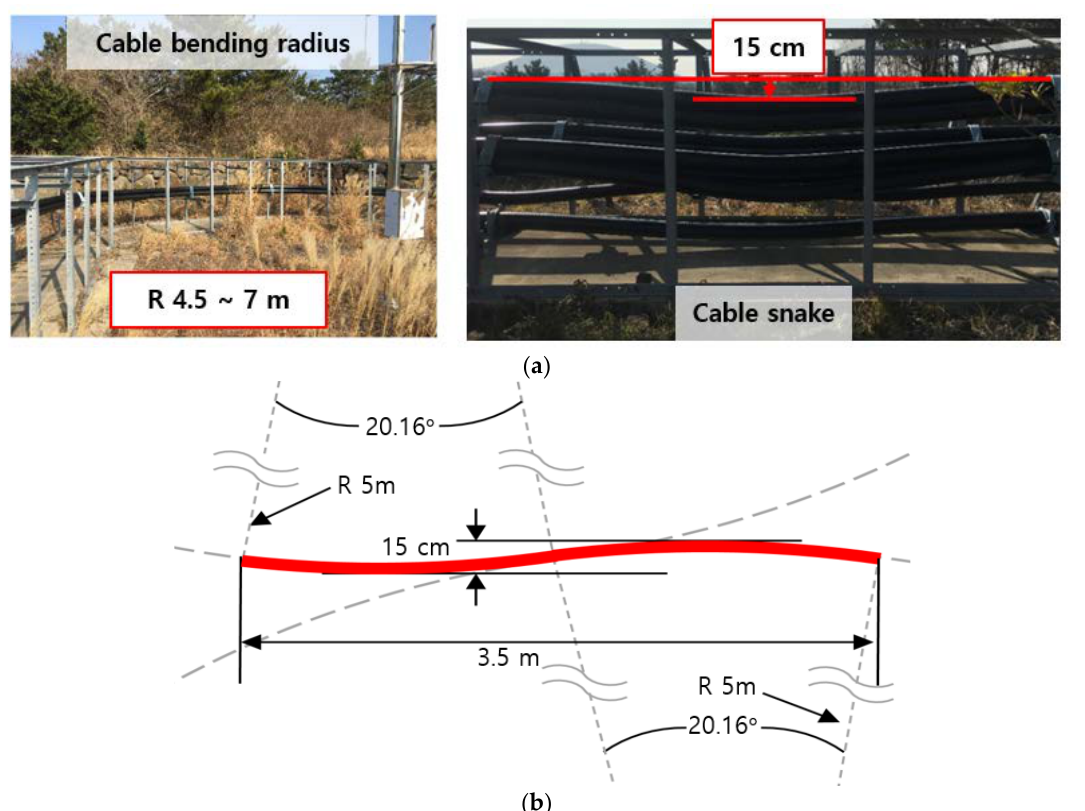
Figure 3. Installation environment in the Jeju smart-grid demonstration center: ( a ) Cable snake and cable bending radius; ( b ) cable snake assumed as bending.